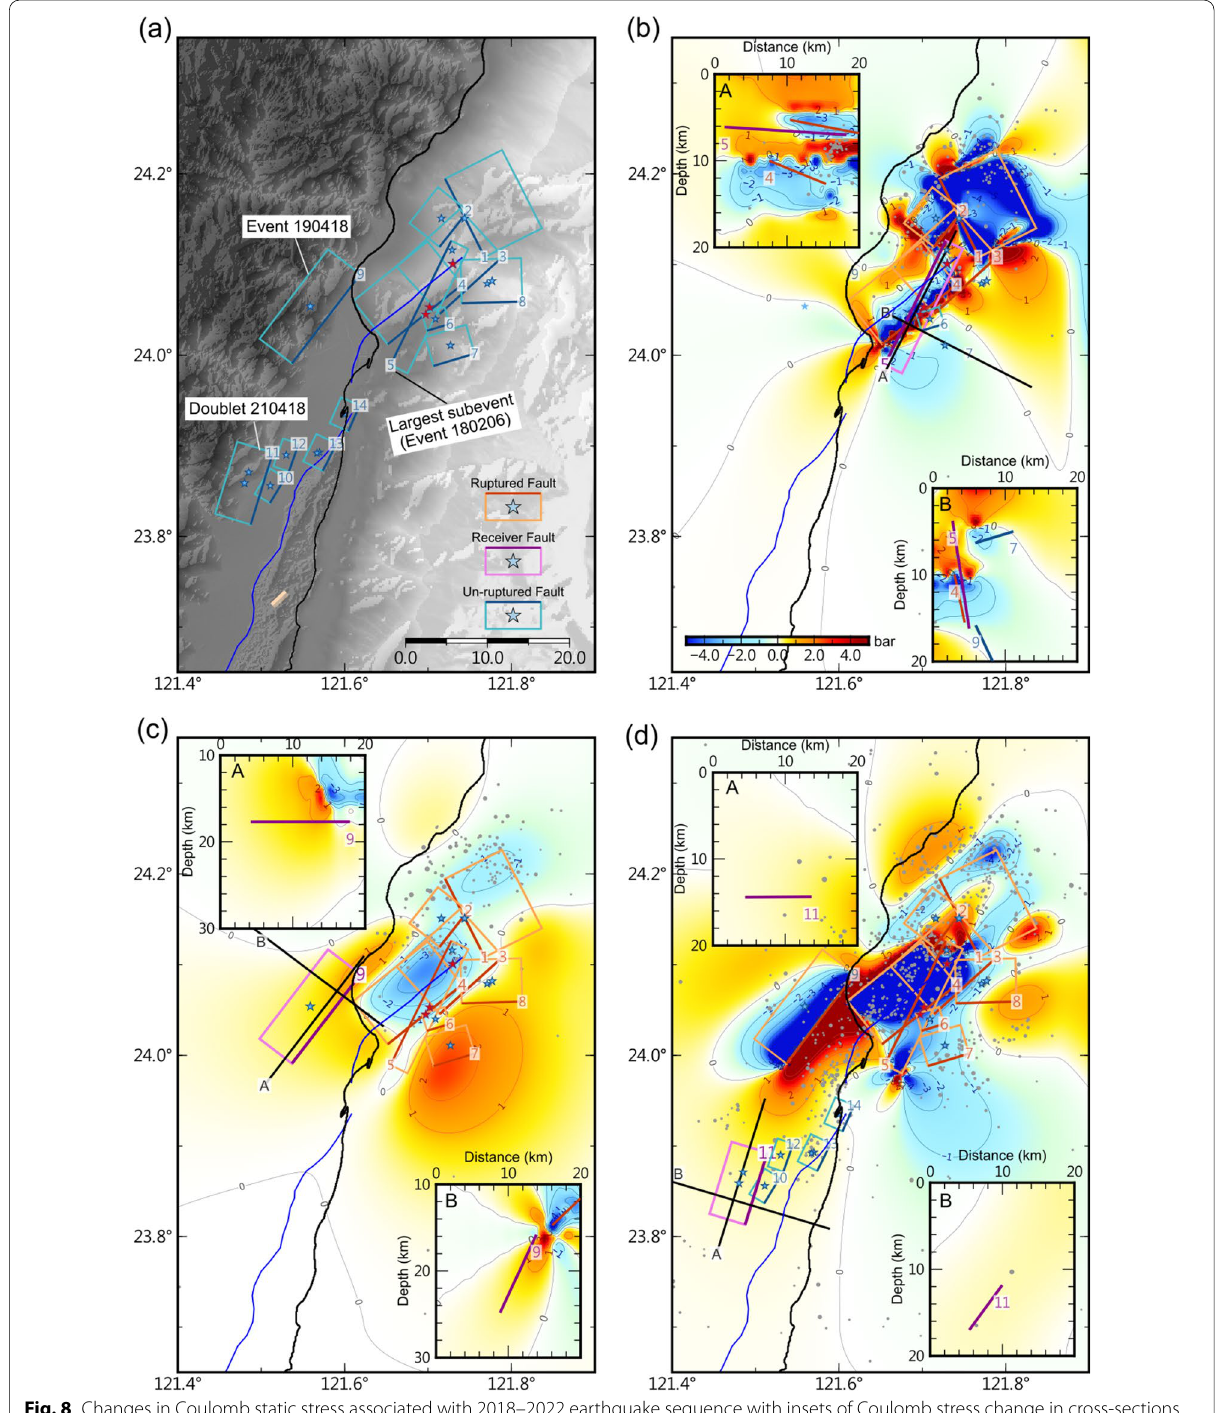
Fig. 8 Changes in Coulomb static stress associated with 2018–2022 earthquake sequence with insets of Coulomb stress change in cross‑sections parallel (A) and perpendicular (B) to strike of receiver fault: a fault configurations of 14 events of 2018–2022 sequence (faults numbered according to order of occurrence); Coulomb stress changes at centroid depth according to receiver faults of ( b ) the largest subevent of 2018 mainshock, c 2019 mainshock, and d 2021 doublet, where rectangles indicate ruptured faults (orange), receiver faults (purple), and faults that ruptured later (blue), thick lines indicate top border of fault plane, and gray dots show aftershocks before receiver fault’s